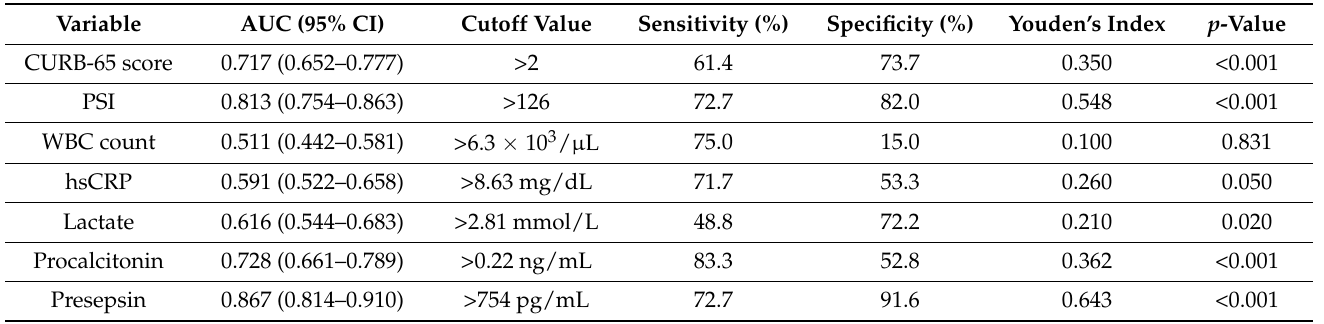
Table 4. AUCs for predicting 30-day mortality.